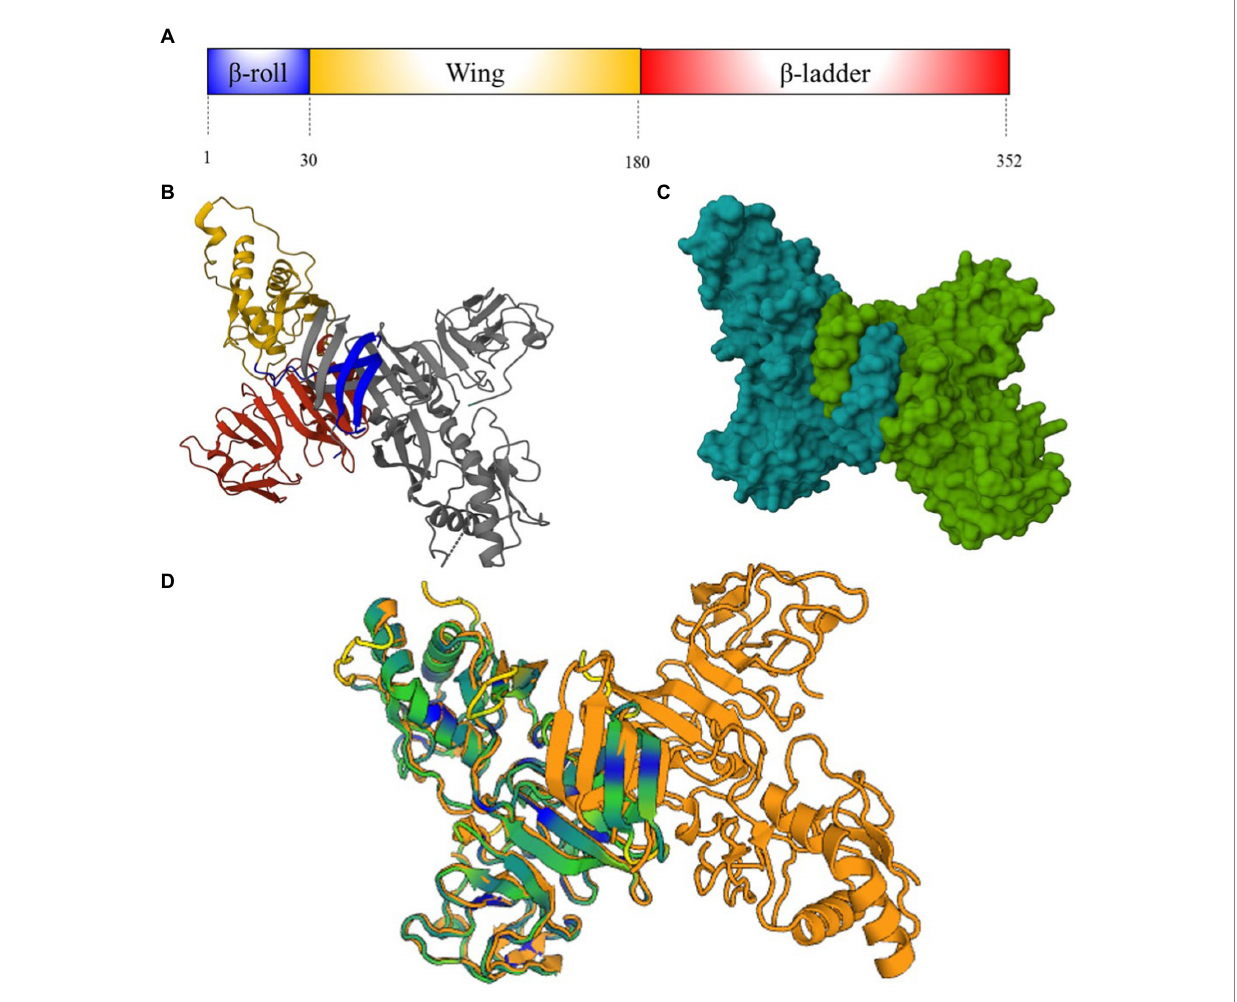
FIGURE 3 NS1 protein structure. (A) Schematic representation of ZIKV NS1-protein showing β -roll (blue), wing (yellow) and β -ladder domain (red). Numbers below represent the residue positions (B) Ribbon molecular structure of ZIKV NS1 cross-shaped dimer (PDB: 5K6K) (Brown et al., 2016). Domains on one monomer are represented as (A) , another domain is showed in gray. (C) Molecular structure of ZIKV NS1 cross-shaped dimer (PDB 5K6K). (D) DENV (4O6B) and ZIKV (5K6K) NS1 superposition [Dali server: (Holm, 2022)]. ZIKV-NS1 sequence A (green) is super posited on DENV-2-NS1 sequence A and B (orange) (Akey and Smith, 2014). Cyan and blue regions indicate conserved motifs and conserved amino acid